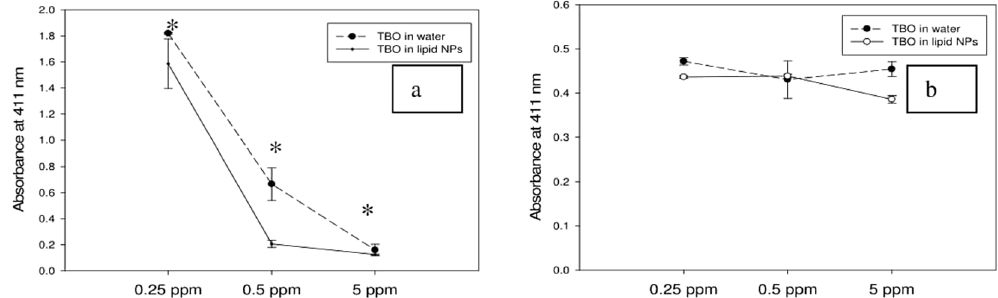
Figure 9. 1,3-DPBF levels in solution after ( a ) light irradiation of TBO in water and TBO in lipid nanoparticles and ( b ) incubation of 1,3-DPBF with TBO in water and TBO in lipid nanoparticles in dark - Lower levels of 1,3- DPBF indicate the generation of a higher amount of singlet oxygen. Encapsulation in lipid nanoparticles led to generation of higher amount of singlet oxygen as compared to TBO in water. Symbols like “ * ” indicate statistical significance between the groups of TBO in water and TBO in lipid nanoparticles; p < 0.05.